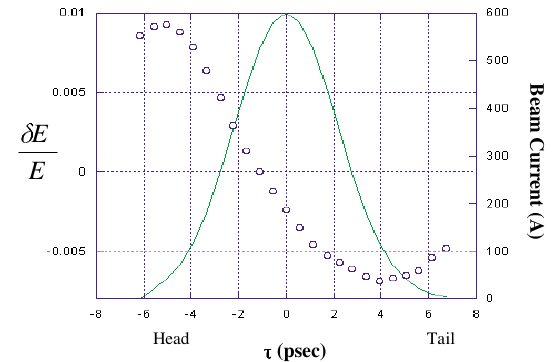
FIG. 5. (Color) The measured correlated energy spread of the beam (open blue circles) and the current distribution (green solid